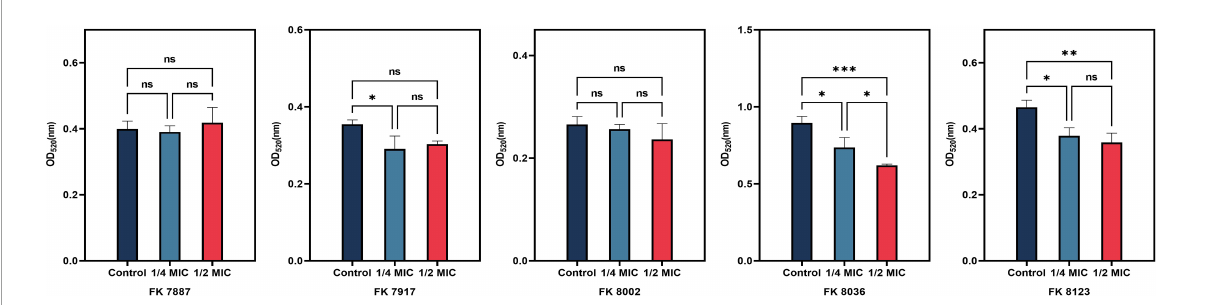
FIGURE4 Capsular polysaccharide inhibition assay. Different color represents different concentrations of chlorogenic acid (CA) [1/2 and 1/4 minimum inhibitory concentration (MIC)] supplemented with carbapenem-resistant Klebsiella pneumoniae (CRKP). “ ∗ ” means P < 0.05, “ ∗∗ ” means P < 0.01, “ ∗∗∗ ” means P < 0.001, and “ns” means P > 0.05.